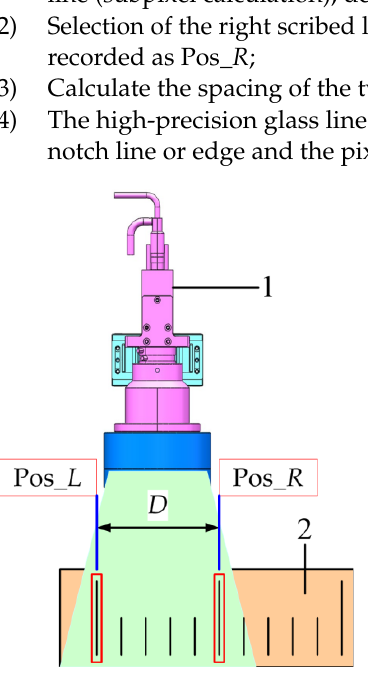
Figure 7. Pixel calibration: 1. Industrial camera (CCD camera); 2. high-precision glass line ruler.